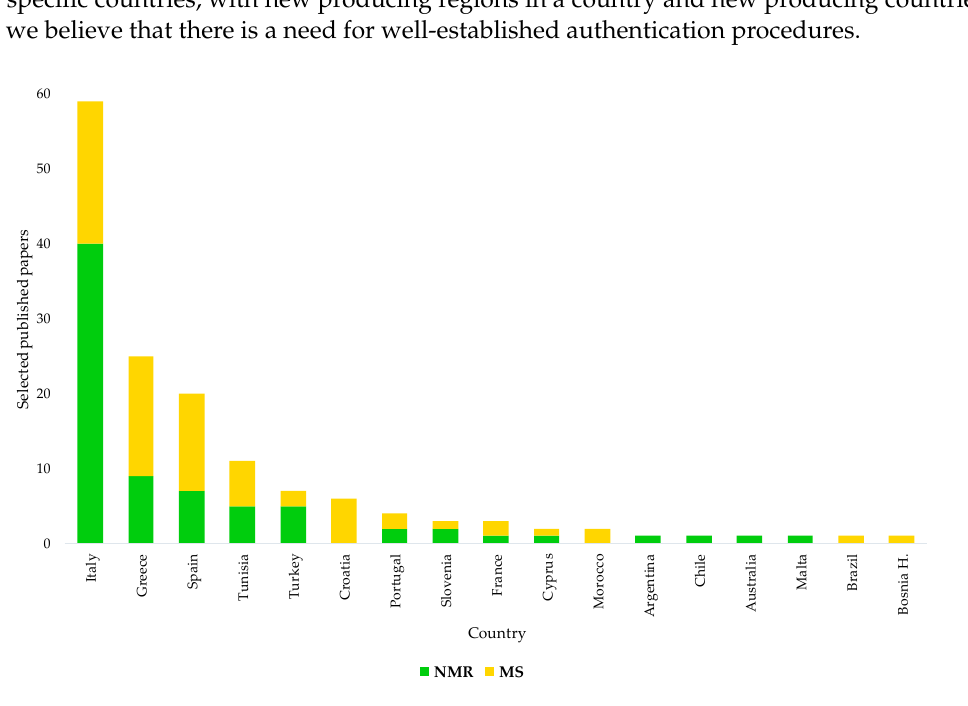
Figure 8. Countries of origins for EVOOs subject to geographical origin assessment in selected NMR and MS-based studies. Data from systematic research on https://www.scopus.com/ and https://scholar.google.com/ (accessed on 1 December 2021).